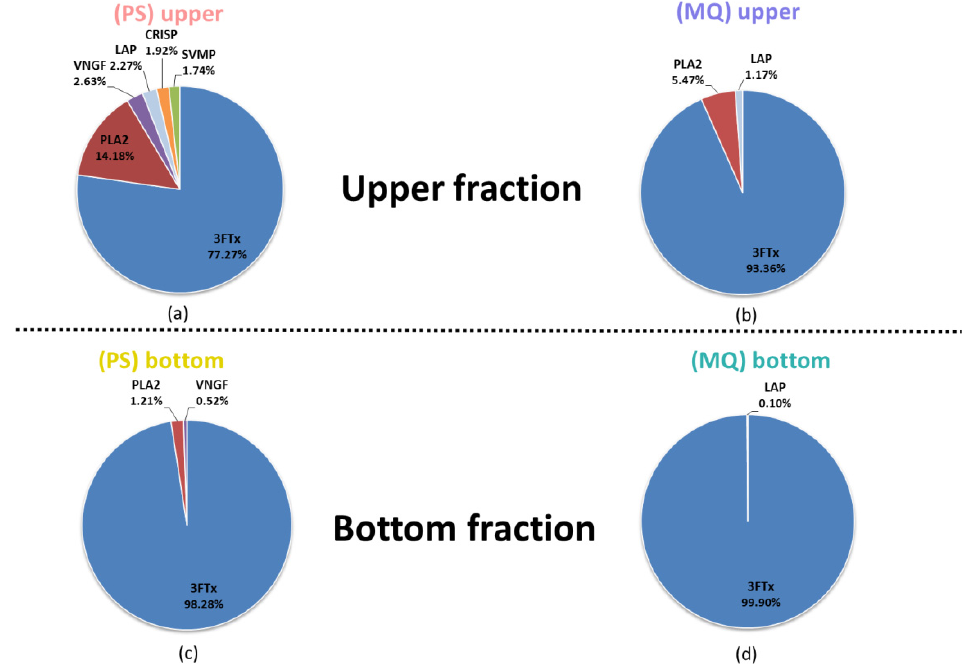
Figure 4. The percentage distribution of different protein families in upper fraction: ( a ) calculated with PeptideShaker (PS); ( b ) calculated by MaxQuant (MQ); and bottom fraction: ( c ) calculated with PeptideShaker; ( d ) calculated by MaxQuant (MQ). LAP (Low abundant proteins)—proteins whose total percentage share did not exceed 1% were included in the LAP group.